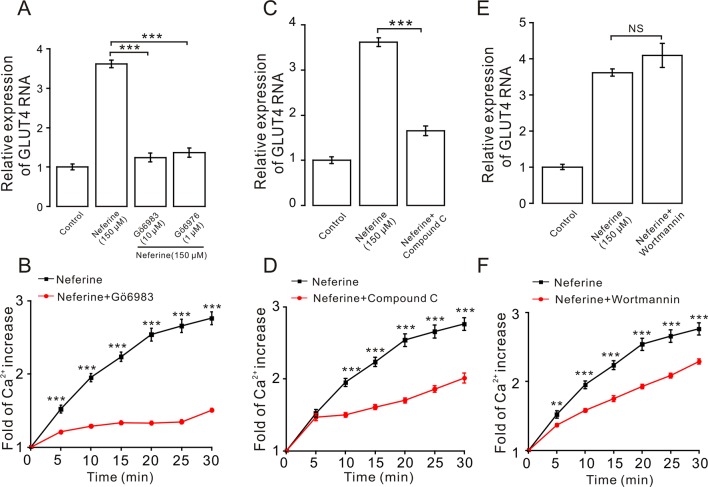
Expression of neferine-induced GLUT4 is mediated by the PKC and AMPK signaling pathways. (A) GÖ6983 (10 µM) and GÖ6976 (1 µM) strongly inhibit neferine-increased GLUT4 mRNA expression. (B) GÖ6983 inhibits Ca2+ concentration enhanced by neferine in L6 cells. (C) AMPK inhibitor compound C (10 µM) also significantly inhibits the increase of neferine-induced GLUT4 expression. (D) Effects of compound C (10 µM) on Ca2+ concentration induced by 150 µM neferine in L6 cells. (E) IP3K blocker wortmannin (10 µM) has no effect on the increase of GLUT4 expression in the L6 cells induced by neferine. (F) Wortmannin (10 µM) has an inhibitory effect on neferine-induced Ca2+ concentration. NS P > 0.05; **P < 0.01; ***P < 0.001.